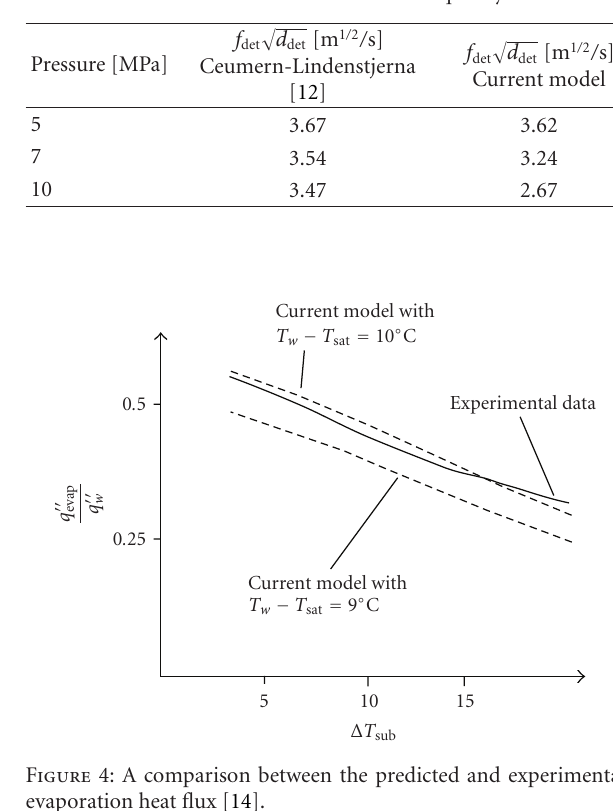
Table 1: Predicted bubble diameter at detachment. Table 2: Predicted nucleation frequency.